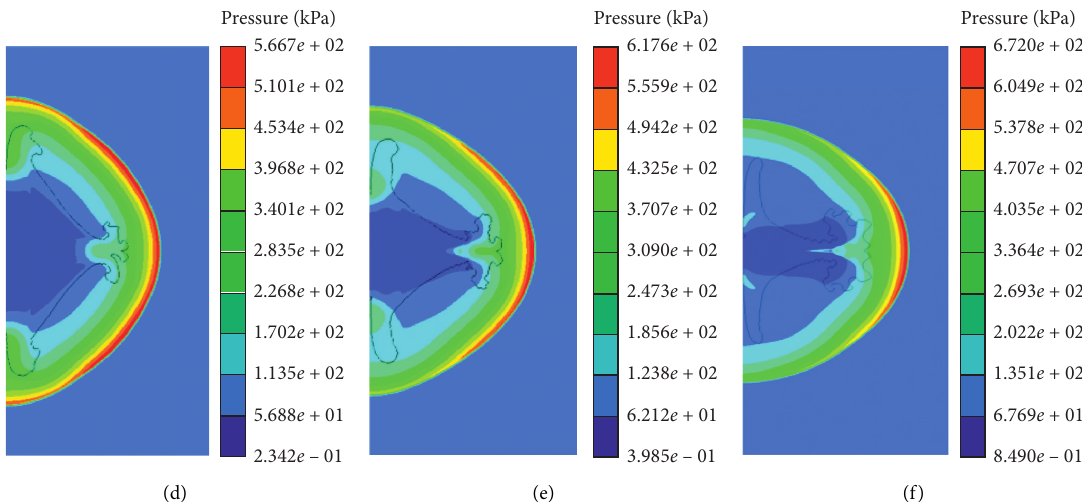
Figure 4: Pressure contours from spherical charge and cylindrical explosives at t � 1.0 ms. (a) Spherical. (b) Cylindrical, L / D � 0.2. (c) Cylindrical, L / D � 0.6. (d) Cylindrical, L / D � 1.0. (e) Cylindrical, L / D � 2.0. (f) Cylindrical, L / D � 5.0.